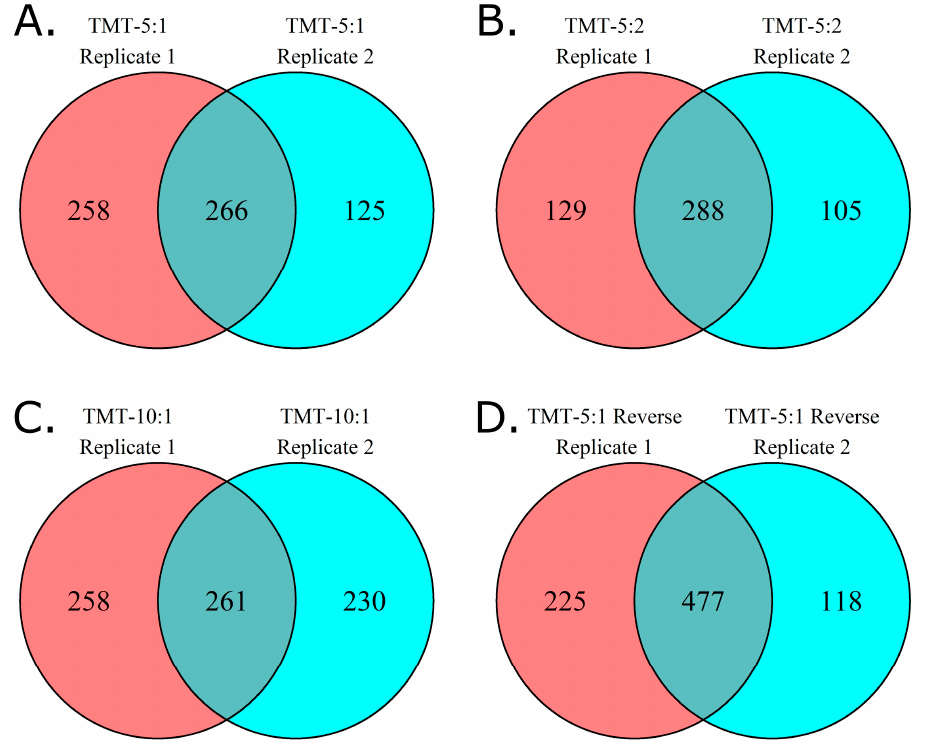
Figure 3. Protein IDs shared between replicates of each method. Each experiment was run twice, using seven plasma samples. Unique protein IDs were compared for all seven samples for each method.